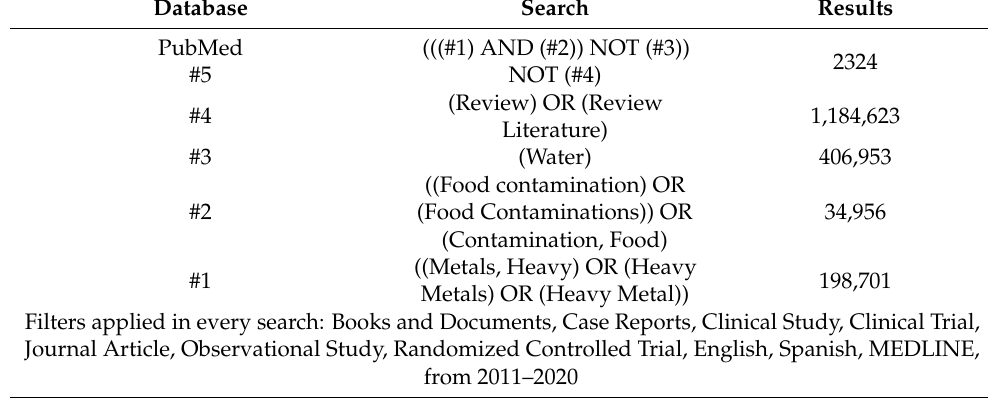
Table 1. Search strategy in